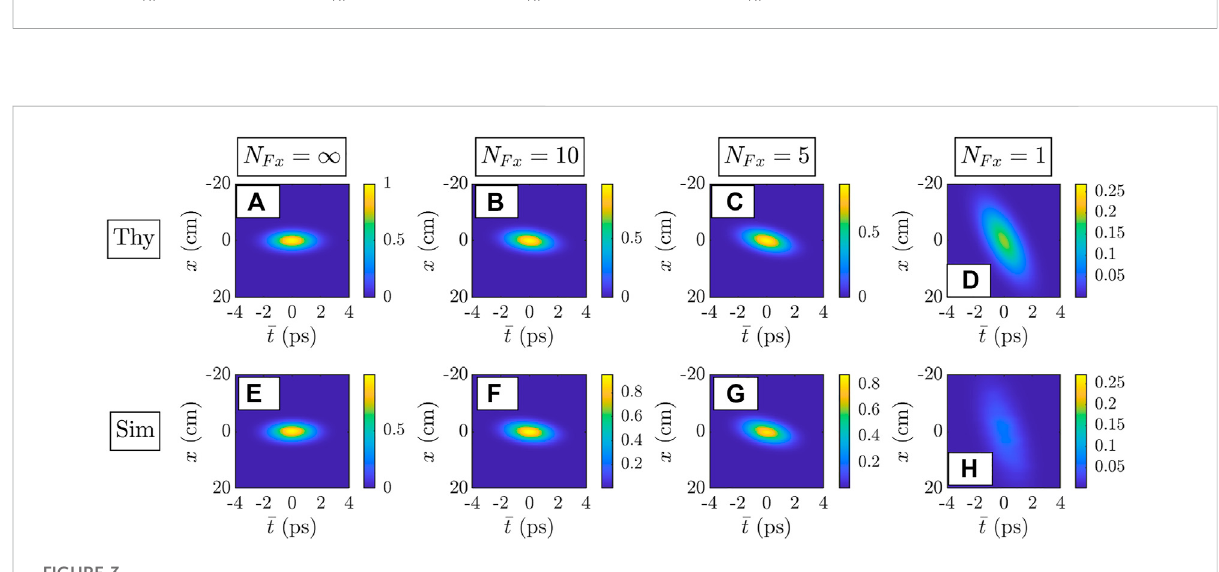
FIGURE 3 Ensemble-averaged irradiance 〈 I ( x , 0 , z , t ) 〉 turbulence results: (A) theory N Fx = ∞ , (B) theory N Fx = 10, (C) theory N Fx = 5, (D) theory N Fx = 1, (E) simulation N Fx = ∞ , (F) simulation N Fx = 10, (G) simulation N Fx = 5, and (H) simulation N Fx =